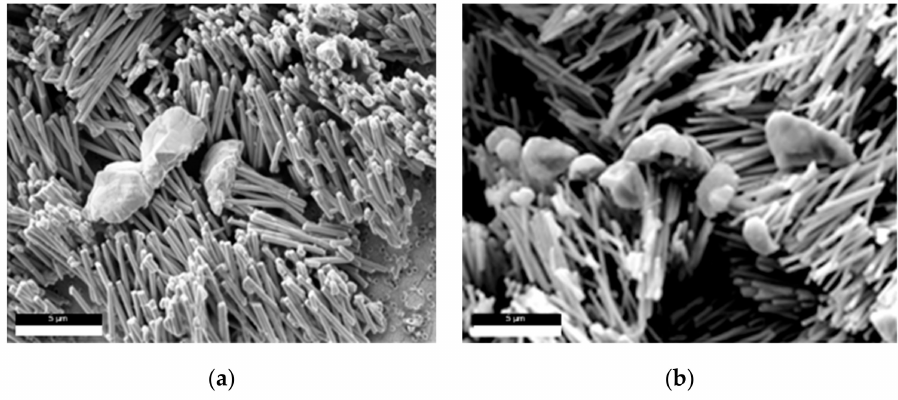
Figure 5. SEM images of Co-Ni nanowire array deposited at − 1.2 V for 3 min ( a ) and 5 min ( b